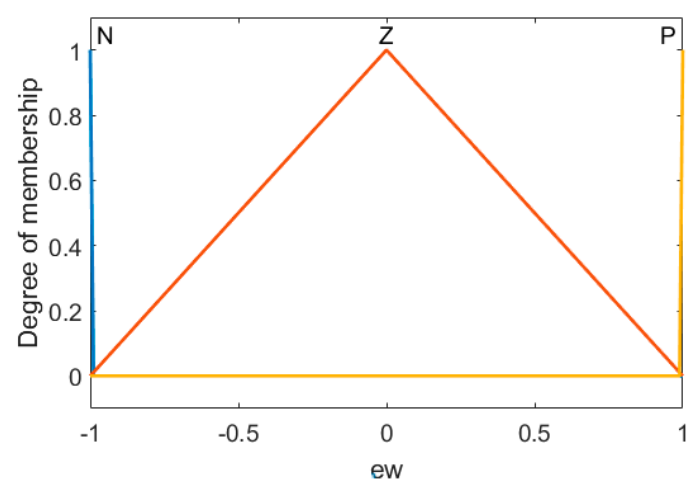
Figure 5. Input linear velocity (ev), not optimized.